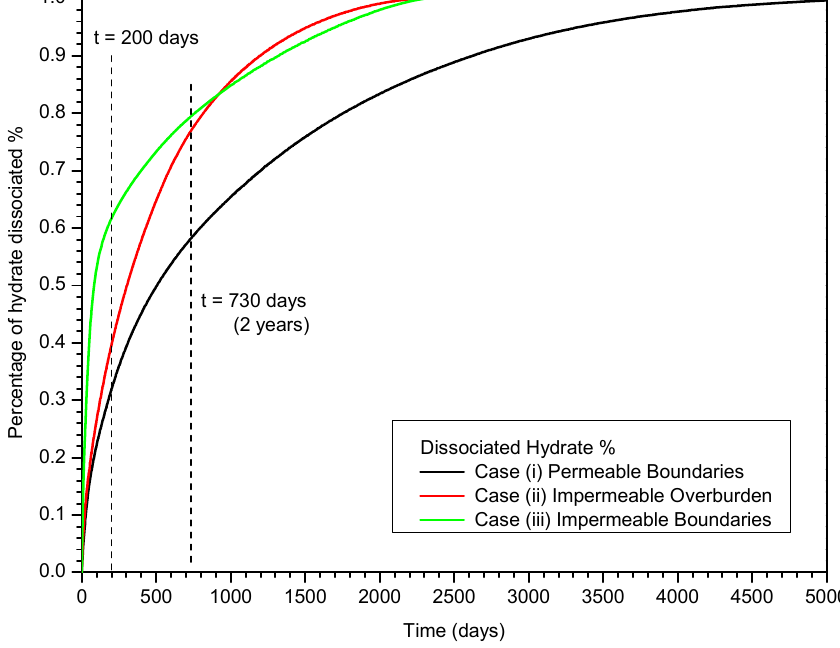
Figure 11. Effect of the permeability of the boundaries on the percentage of hydrate